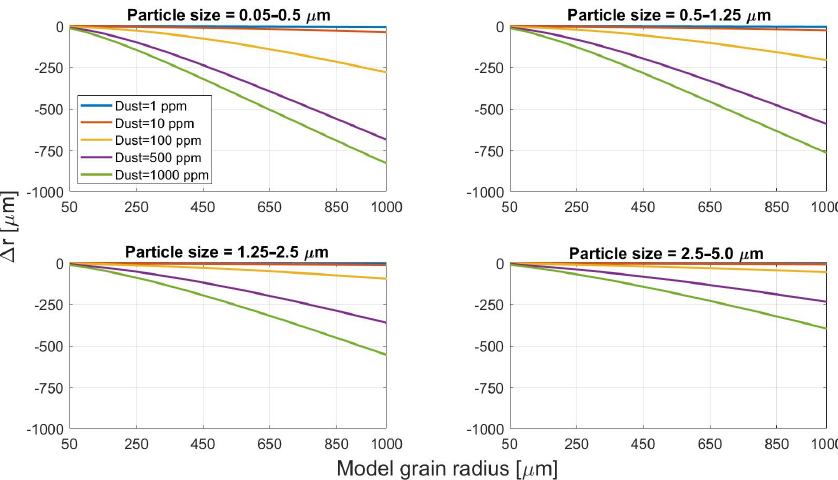
Figure 8. Grain size retrieval biases for San Juan dust of four size distributions. Biases are relative to a clean snow case (i.e., dust = 0ppm).